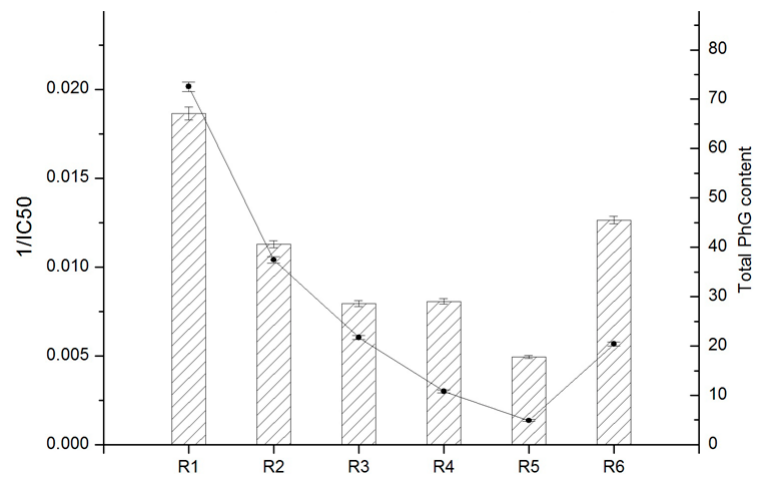
Figure 9. Comparison of the total PhG content and DPPH radical scavenging activity (1/IC 50 ) of six different parts from cultivated C. deserticola . Data are presented as mean ± SD of each of three replicates ( n = 3).